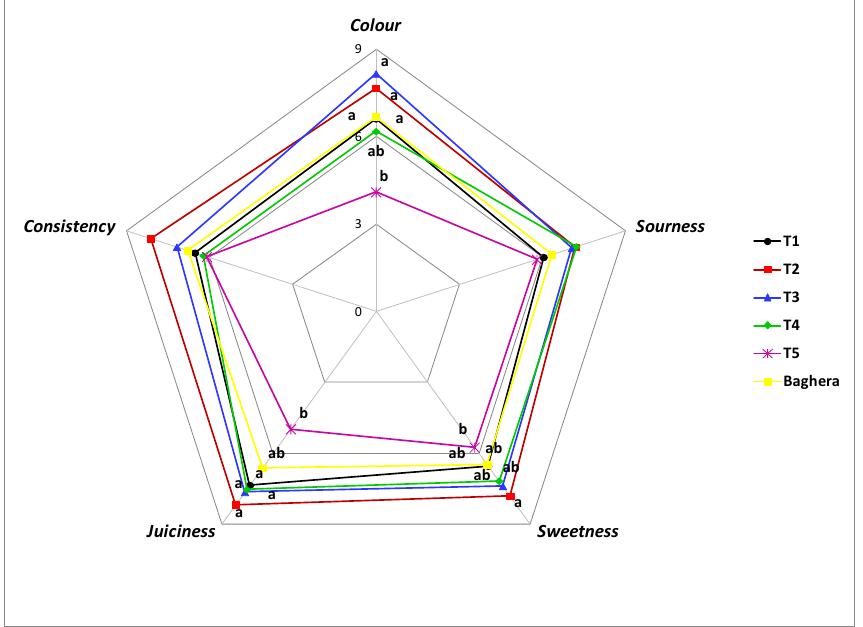
Figure 6. Sensory evaluation results of tomato in the light-red stage. For each quality parameter, samples with different letters differed at a significance level of 0.05 according to the Tukey’s test (n=8).